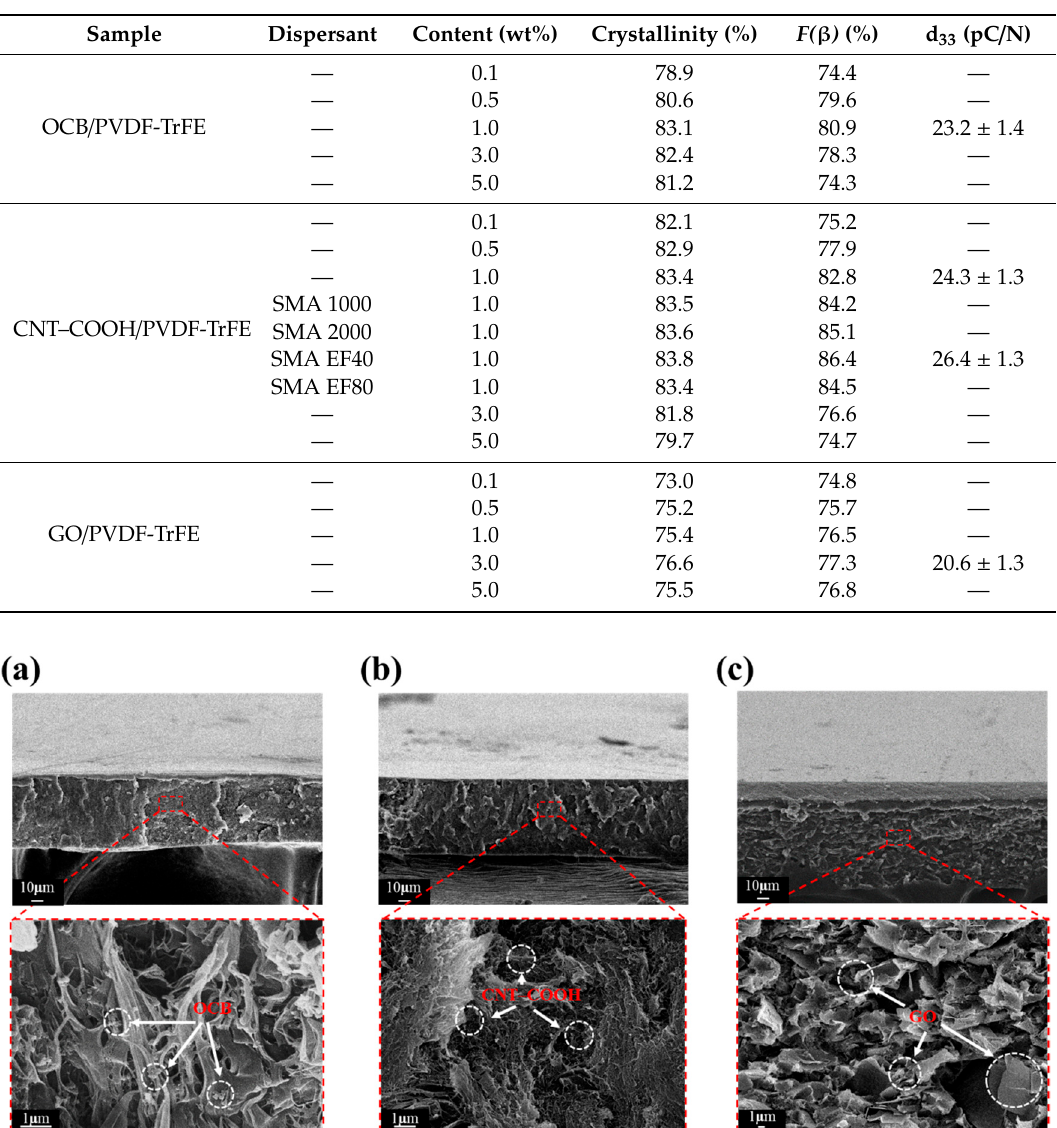
Table 2. Measurement results of the crystallinity, β -phase percentage, and piezoelectric coe ffi cient of nanocarbon / PVDF-T.